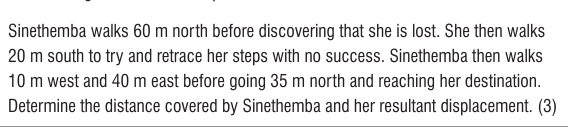
Table 5: Pass rates for formative Test One for each